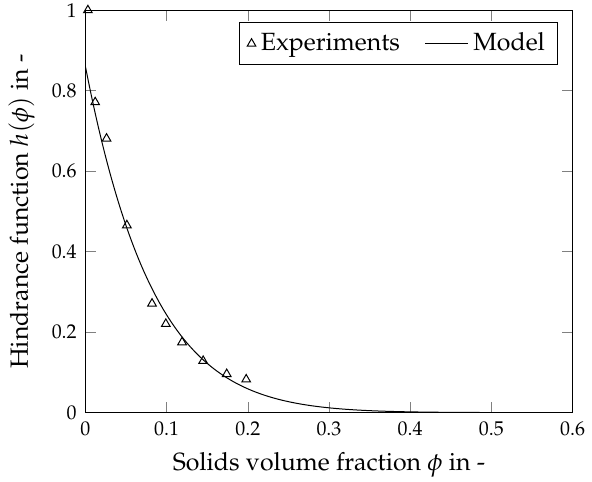
Figure 3. Hindrance function of Kaolin: The experimental results and the fitting (model) used for the simulation to describe the hindrance settling function in dependence of the solids volume